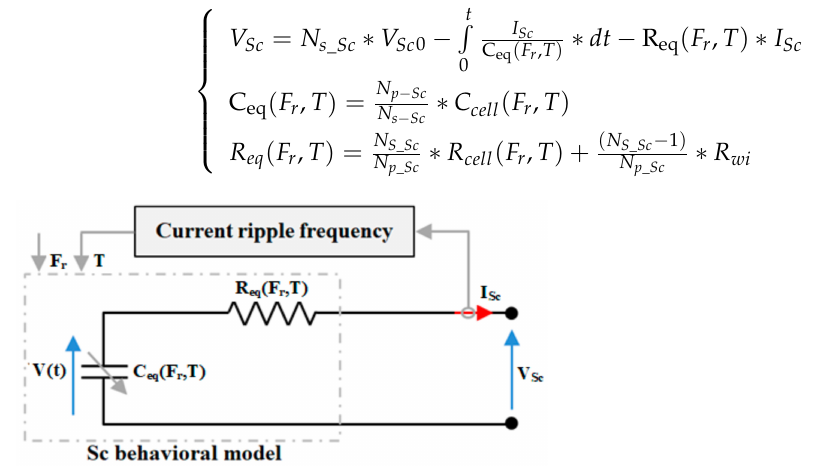
Figure 5. Behavior model of the Sc pack. Table 3. Sc model parameters based on Boostcap 3000F/2.7V